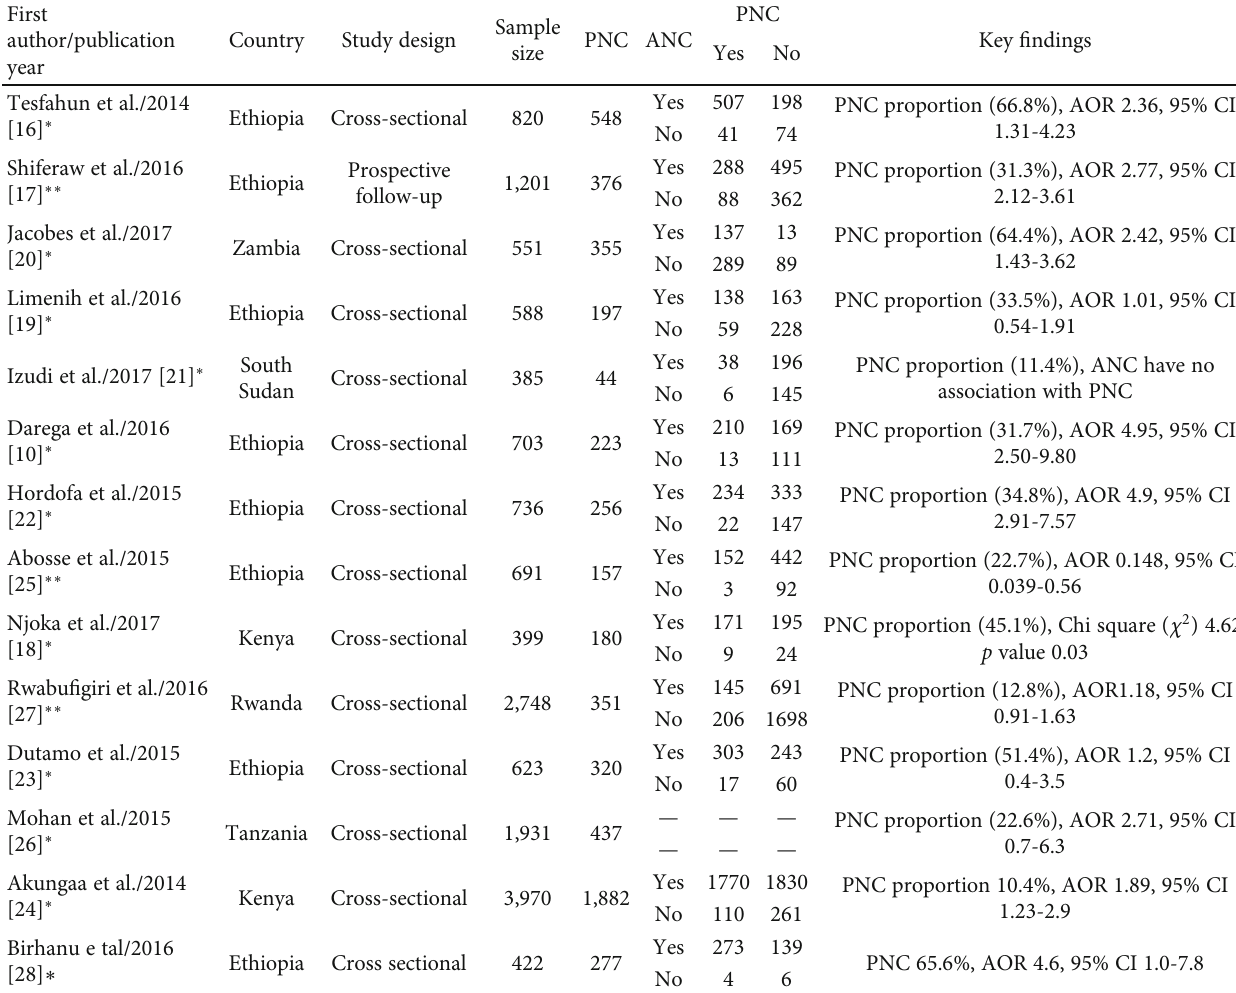
Table 1: Characteristics of studies included in a systematic